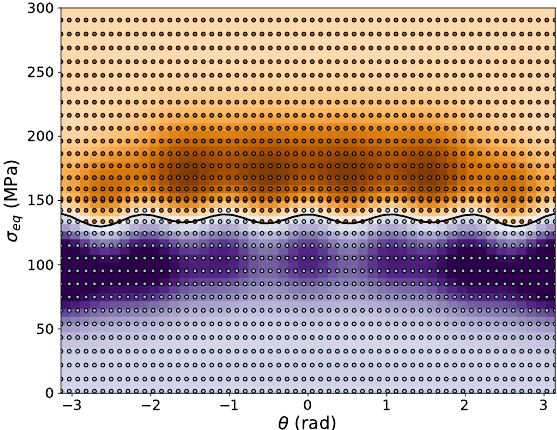
Figure 8. Field plot of the ML yield function trained with data generated from a reference material with a Tresca yield criterion, where areas in purple color shades represent negative values and brown shades represent positive values. The isoline, where the ML yield function is zero, is plotted as black line. The test data points are plotted as brown circles, for stresses in the plastic regime, and a s light blue circles for stresses in the elastic regime.